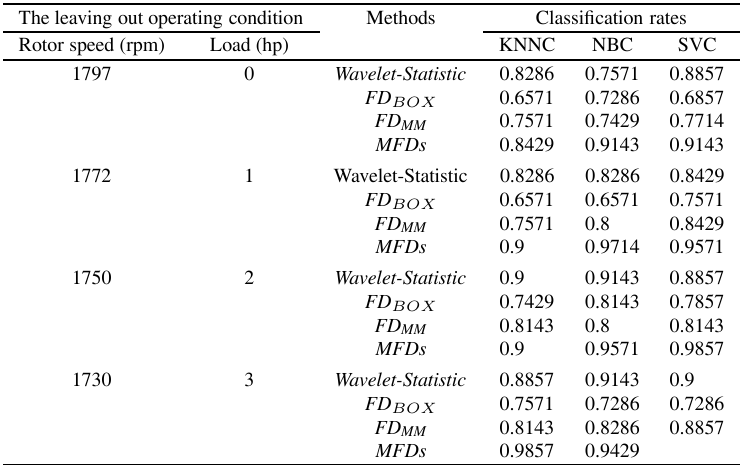
Table 3 Performances of Wavelet-Statistic, FD BOX , FD MM and MFDs using the three classi fi ers on four ‘ leaving one operation condition out ’ bearing